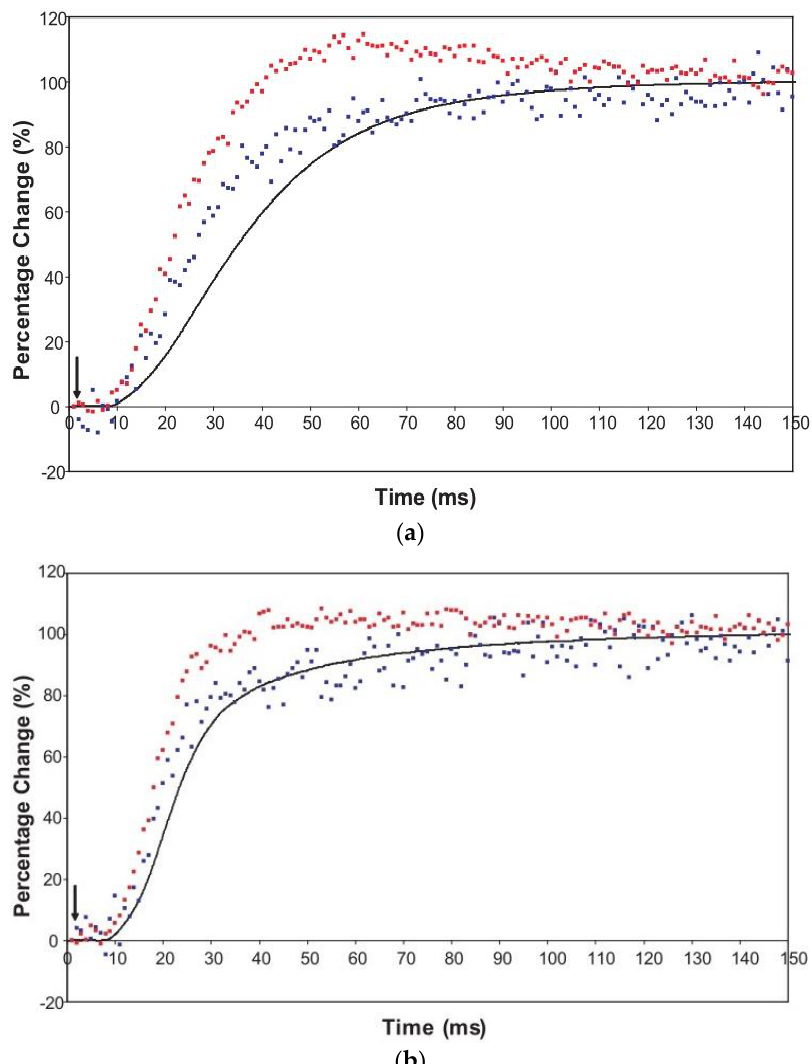
Figure 4. Average time-courses of the A(10) and A(11) intensities and tension during the 150 ms rising phase of isometric tetanic contraction in Plaice fin muscle without and without SL control. The inverted A(10) time-course, actually a drop in intensity, is shown in blue, the A(11) increase in red and the tension increase in black. Time-courses have been normalised with respect to their average values over 100 ms in the relaxed state (0%) and 100 ms at the plateau of contraction (100%) to show the percentage of maximum change. Activation occurs at the position of the black arrow. ( a ) Time-courses of the A(10) and A(11) intensities and tension without SL control. ( b ) Time-courses of the A(10) and A(11) intensities and tension with partial SL control